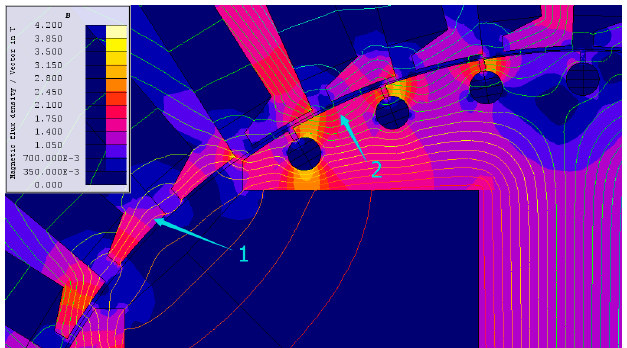
Figure 12. Flux distribution and magnetic flux line near the air gap at 0.01 s after the short circuit. 1 is the gap leakage flux line of the field winding, and 2 is the gap leakage flux line of the stator